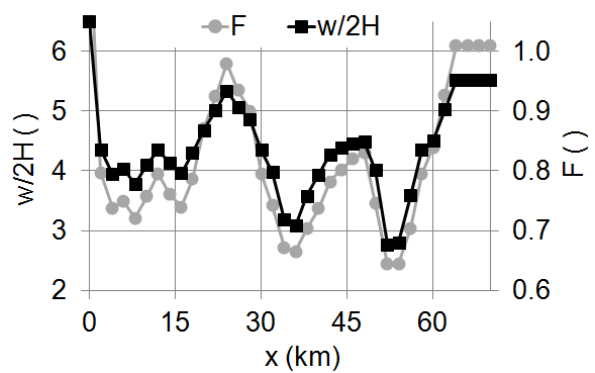
Fig. 2. Observed pre-retreat ratio of glacier half-width to ice thick- ness ( w /(2 H)) along the centerline of Columbia Glacier, with the corresponding spatially variable correction factor ( F) applied to the ice flow model in this